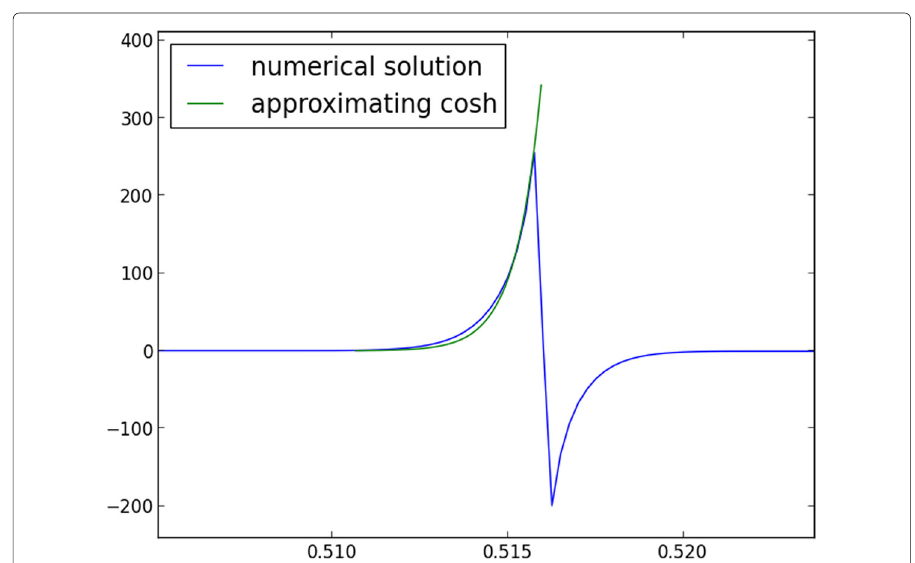
Fig. 3 Cosh profile of delta spike. Comparison of a delta spike with a cosh profile of form (20). Note that the cosh profile shown here is not a best fit, but rather an analytically derived approximation, as discussed in the Appendix. The delta spike comes from a simulation with parameters (cid:6) = 2.5 e − 6, dx = 2.5 e − 4, and initial data u ( x ,0 ) = sin ( 2 π x ) + .1. Again, the positive and negative spikes must be added together to give the